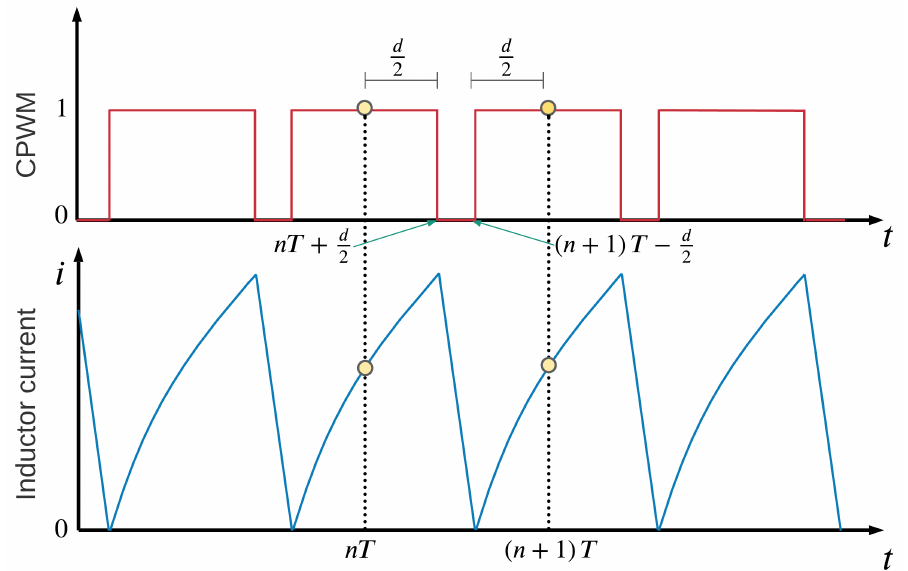
Figure 3. Symmetrical centered pulse-width